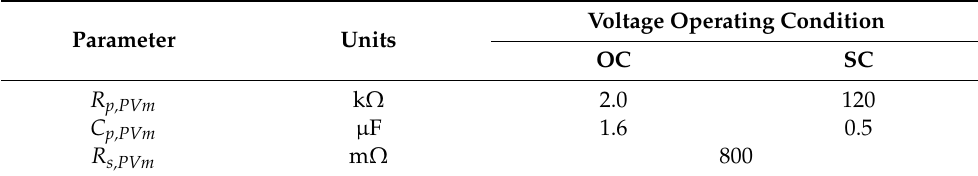
Table 4. Value setting adopted for parameters in simulations at OC and SC conditions.